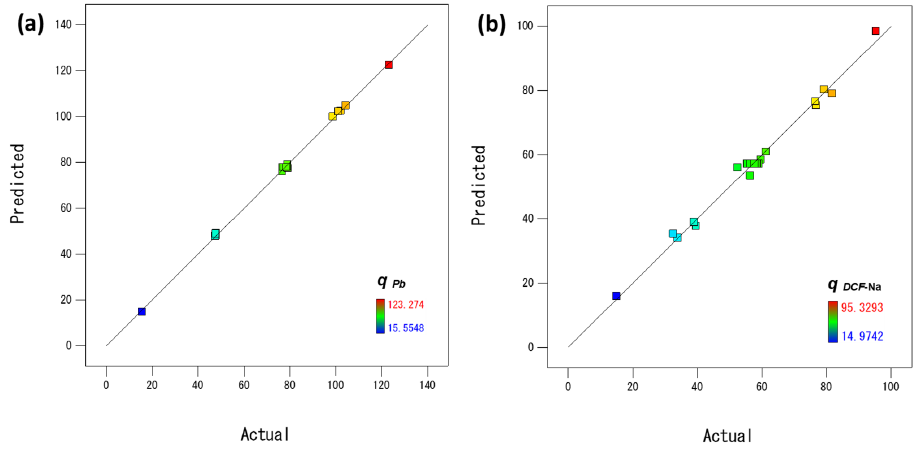
Figure 7. Plots of experimental versus predicted responses for q Pb ( a ) and q DCF ‐ Na ( b